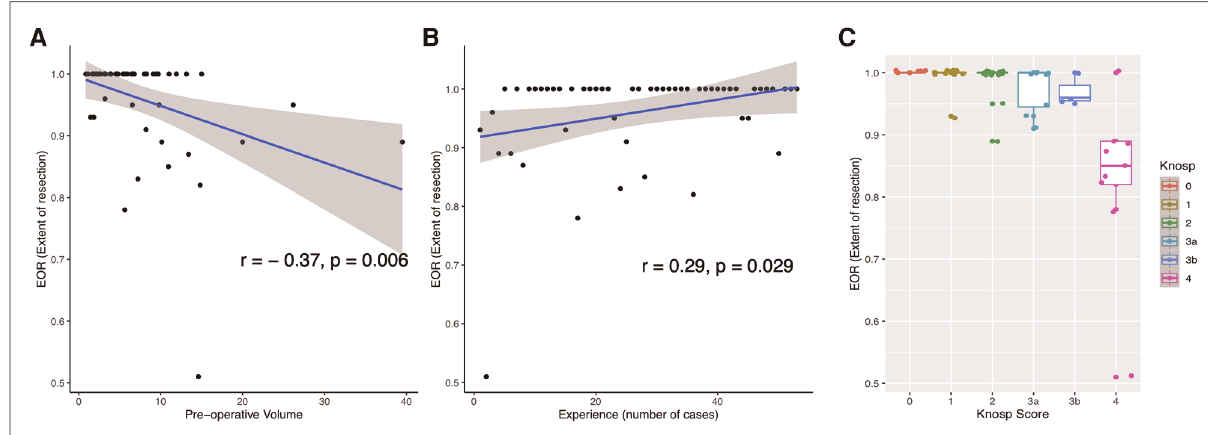
FIGURE 1 Representation of factors correlated with EOR (Extent of resection). ( A ) Scatterplot showing the correlation of EOR with pre-operative volume. ( B ) Scatterplot showing the correlation of surgical experience with EOR. ( C ) Boxplot showing the EOR depending on Knosp